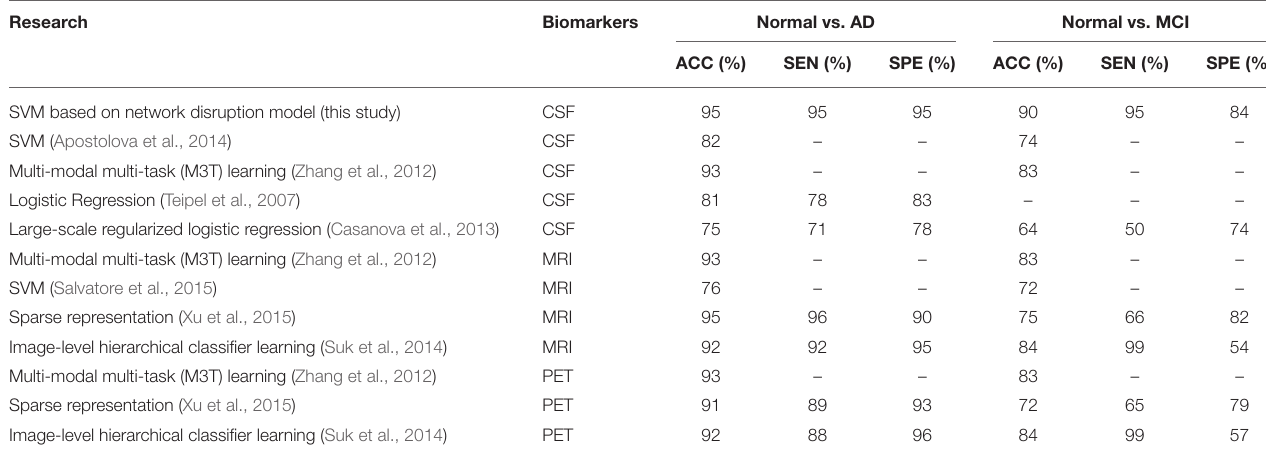
TABLE 4 | Comparison to previous researches.